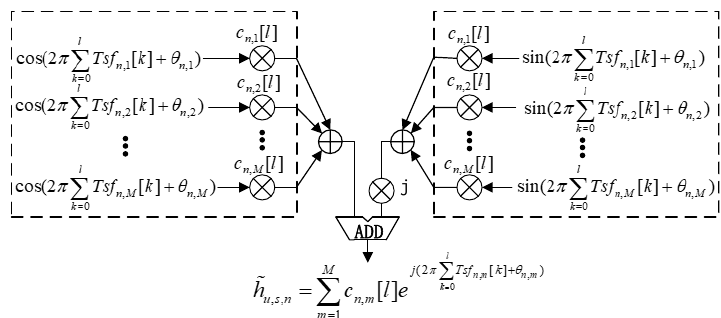
Figure 2. Sum-of-frequency-modulated-signals (SoFM)-based channel fading